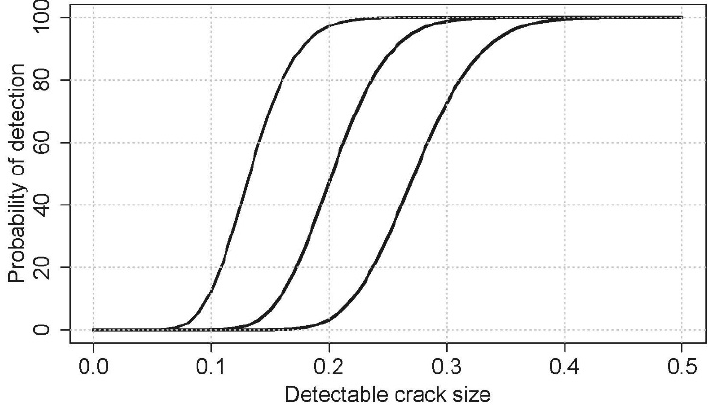
Figure 9. POD curves represent inspection effectiveness concerning the crack size. Curves with shape parameters PD equal 20, 30, and 40 are shown from left to right, respectively.